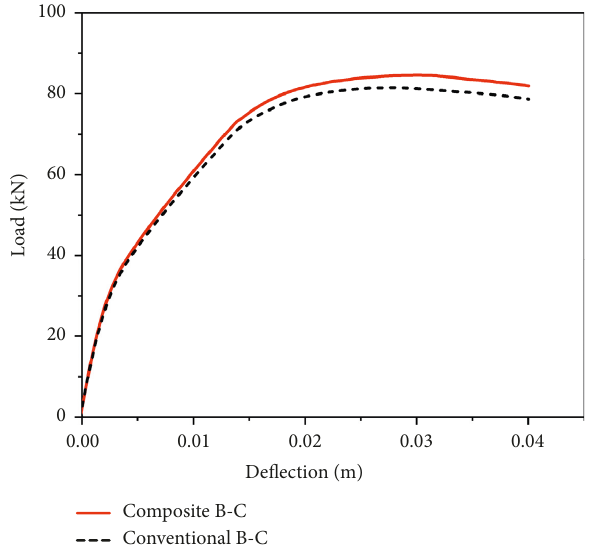
Figure 13: Comparison of load-displacement responses of conventional and composite beam-column joints at the beam-free